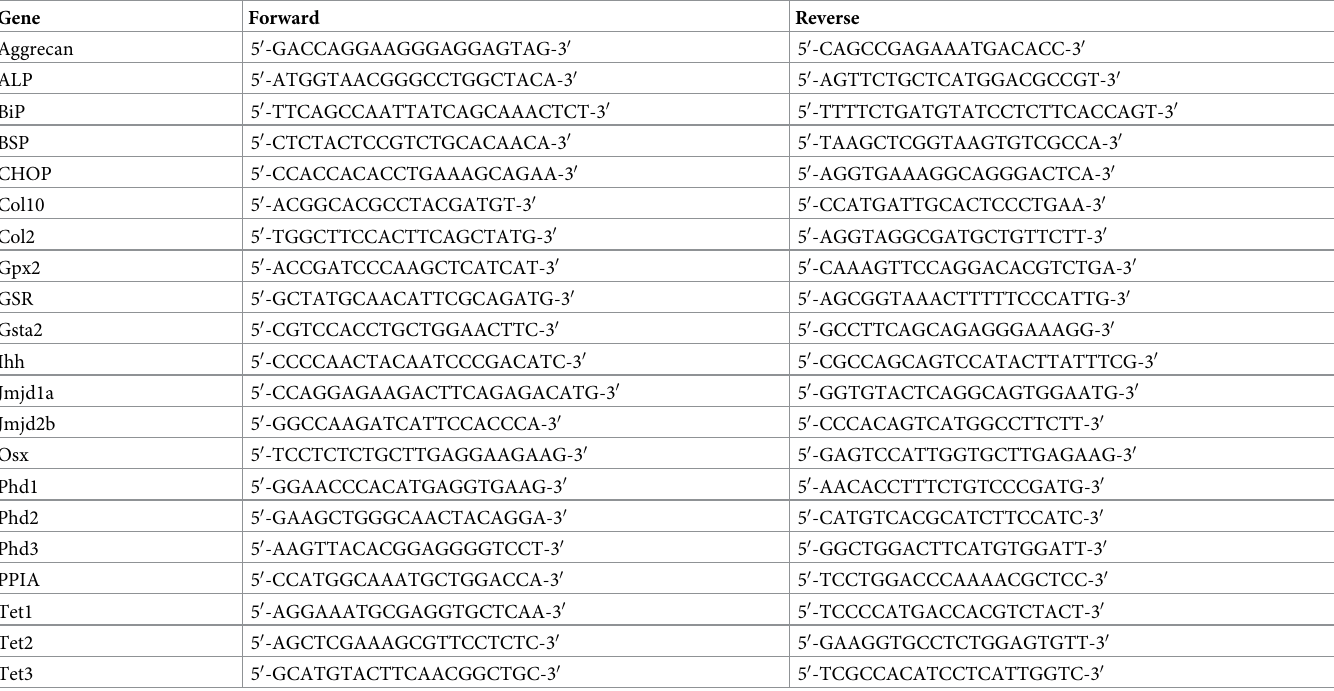
Table 1. Primer sequences for real-time PCR.